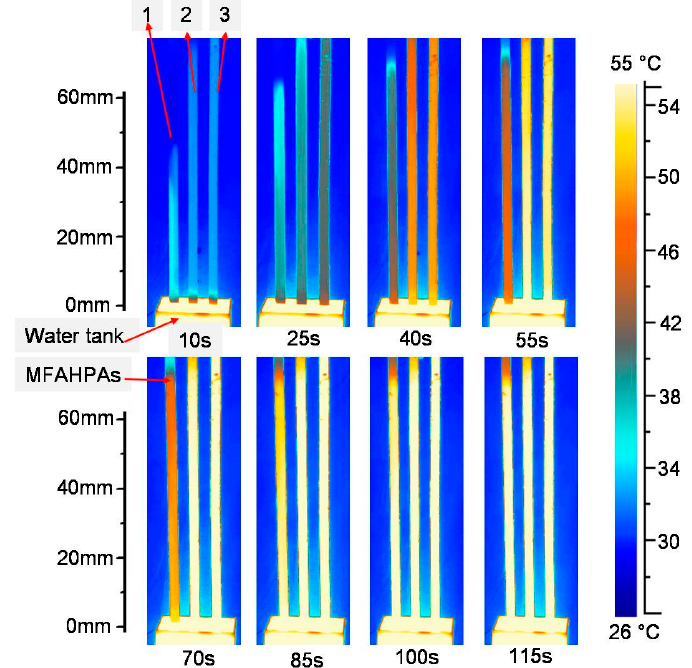
Figure 8. Evaluation of temperature uniformity by an infrared camera during the start-up stage: (1) n-hexane; (2) cyclopentane; and (3) acetone.